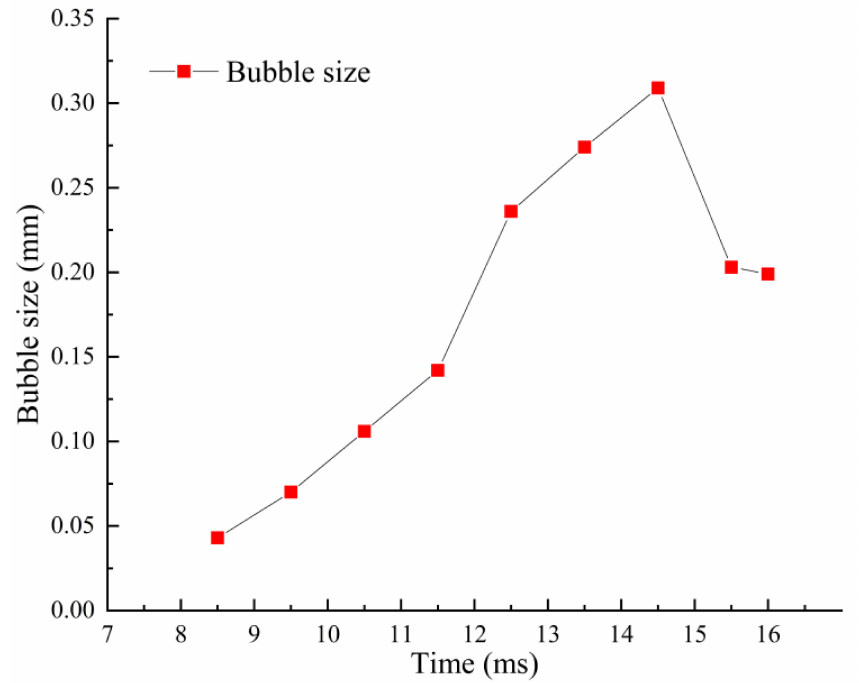
Figure 4. The variation in the size of a sliding bubble.